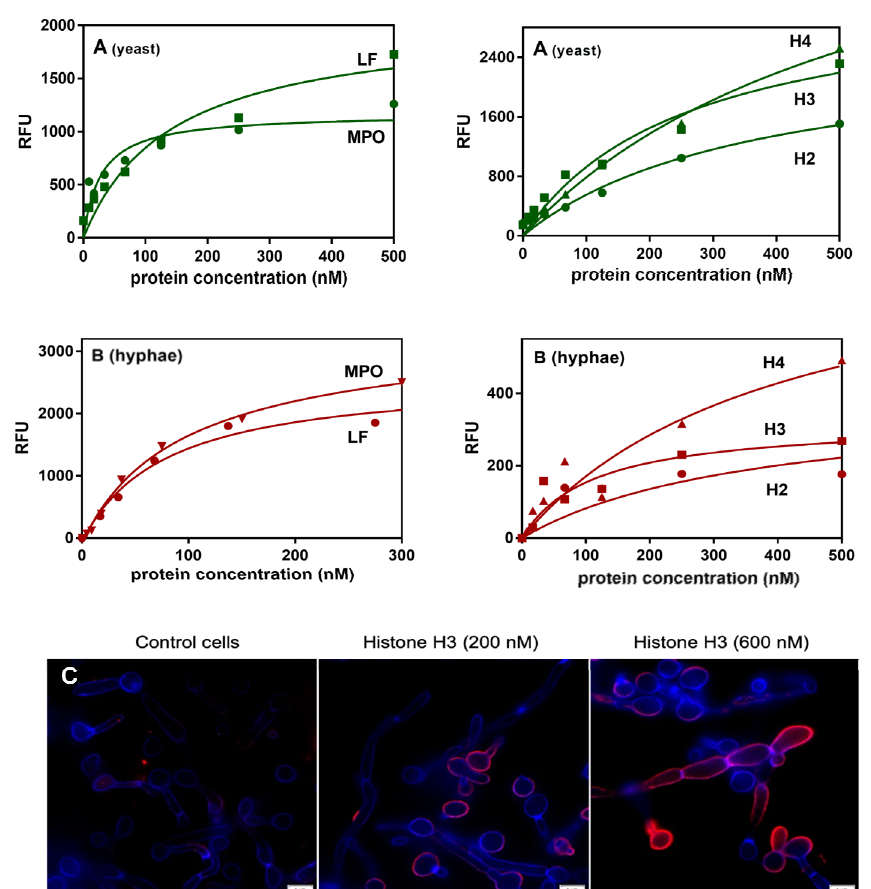
Figure 3. Interactions of selected NET proteins with the yeast and hyphal forms of C. albicans cells. The interactions of commercially available NET-composing proteins were tested using flow cy- tometry analysis ( A ) for the yeast-like form, and the microplate ligand-binding assay ( B and C ) for the hyphae. In the flow cytometry experiments, 1.3 × 10 6 C. albicans cells were incubated in the presence of selected proteins, previously labeled with NHS-fluorescein. The results were presented as a mean fluorescence intensity per cell. In the microplate assay, the binding of fluorescein-labeled towards C. albicans hyphal forms (1 × 10 6 cells) grown in RPMI 1640 medium for 3 h at 37 ◦ C. NET proteins was tested towards C. albicans hyphal forms (1 × 10 6 cells) grown in RPMI 1640 me- dium for 3 h at 37 °C. After washing and blocking the unbound surfaces, the cells were incubated with labeled NET proteins. The amount of bound proteins was determined by measurements of the with a multi-mode microplate reader. For all of the experimental data, the protein binding analysis